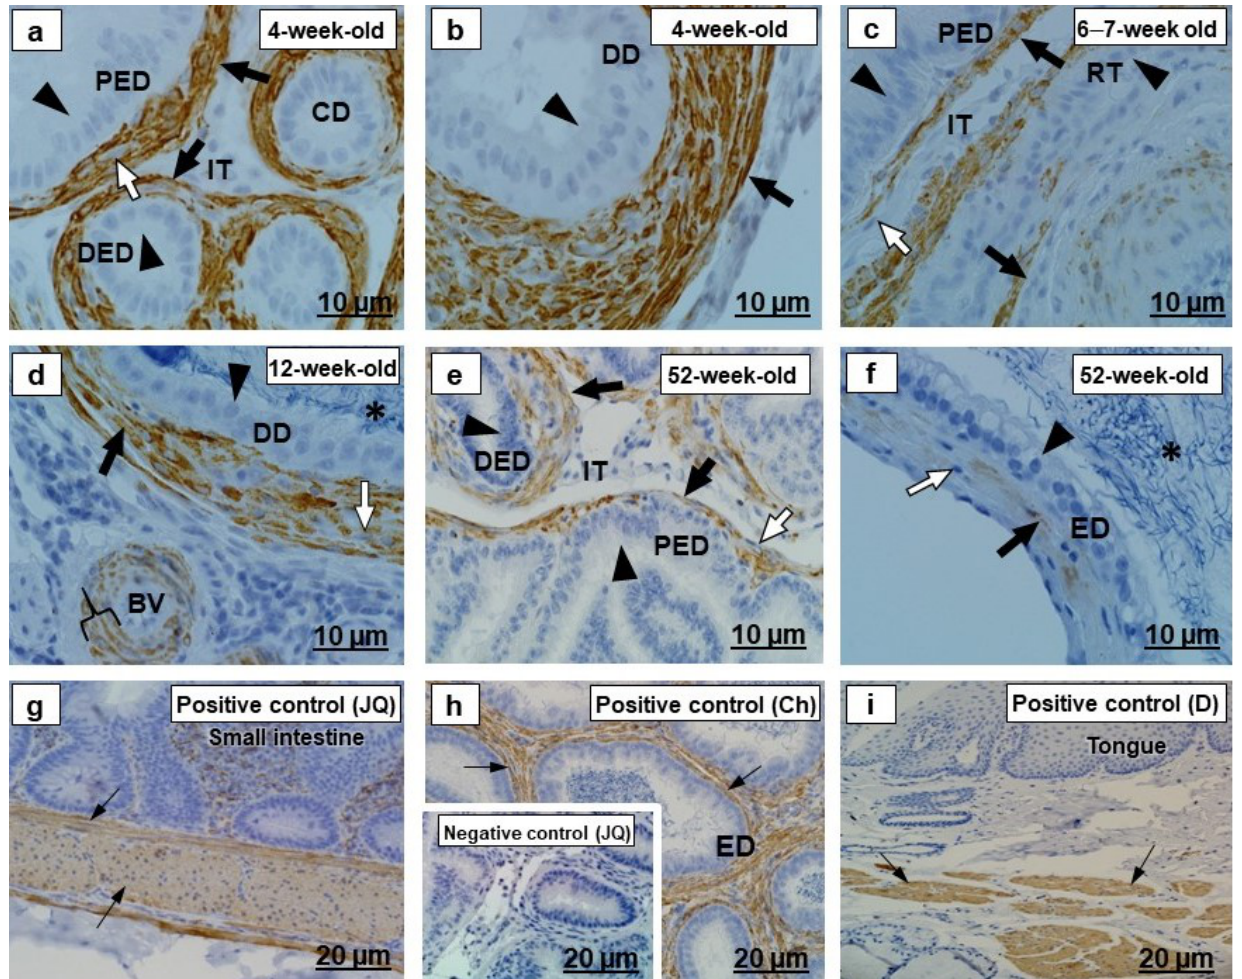
Figure 3. Desmin immunolocalization in the testicular excurrent duct system of Japanese quails ( n = 7 per age group). ( a – f ) Immunonegative epithelial cells (arrowheads), fibroblasts (white arrows) and the interductal tissue (IT) of the testicular excurrent duct system. ( a , b ) Black arrows indicate strong immunostaining in the periductal smooth muscle layers. ( c , d ) Moderate to strong immunostaining in the periductal smooth muscle layers (black arrows). ( d ) Bracket shows moderate immunostaining in the tunicae media of the interductal blood vessel. ( d , f ) Immunonegative spermatozoa (asterisks). ( e , f ) Black arrows depict weak to moderate immunostaining in the periductal smooth muscle layers. Inset ( h ) Negative control: Efferent ducts of an adult Japanese quail. ( g – i ) Positive controls: Thin black arrows depict immunopositive labeling in the smooth muscle layers of the small intestine of the adult Japanese quail ( g ), epididymal duct of the chicken ( h ), as well as in striated muscle in the tongue of the dog ( i ). RT, Rete testis. PED, Proximal efferent duct. DED, Distal efferent duct. CD, Connecting duct. ED, Epididymal duct. DD, Ductus deferens. BV, Blood vessel. Ch, Chicken. D, dog. JQ, Japanese